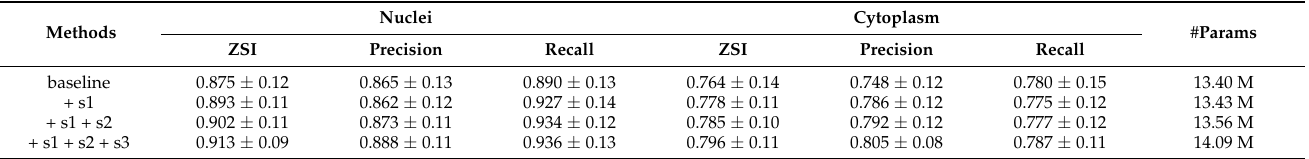
Figure 6. Visual results of embedding the GDLA module at different stages of U-Net. Table 3. The results of embedding the GDLA module at different stages of U-Net. The values are in the format of µ ± σ